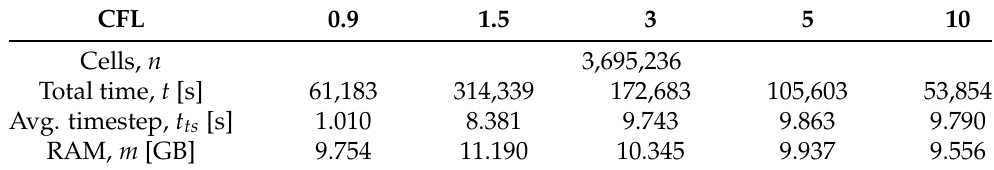
Figure A1. Concentration of passive scalar c at z / D = 1.5, z / D = 3, z / D = 4.5 (top to bottom) for different values of Sc t where y / D = 0. Fine grid and k − ω TNT model. Table A1. Performance on the fine grid for different CFL values. Assessment is made for the k − ω TNT model. Presented values are three-run averages. A total of 48 cores are used for all tests. Due to numerical instabilities, the number of outer loops had to be increased ( n loops = 50) for Co max > 0.9.